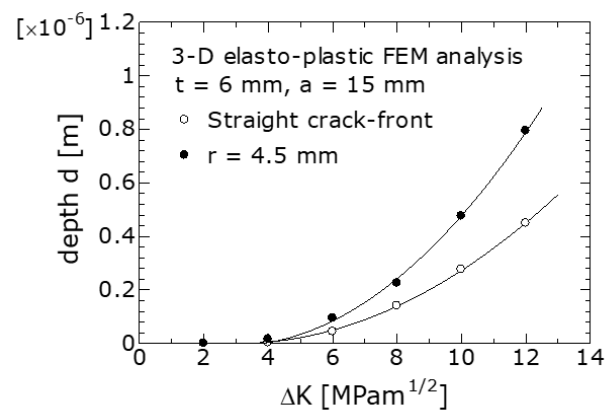
Figure 12. Effect of the radius of curvature r of the leading edge of the crack on the d value. t = 6 mm, crack length a = 15 mm.